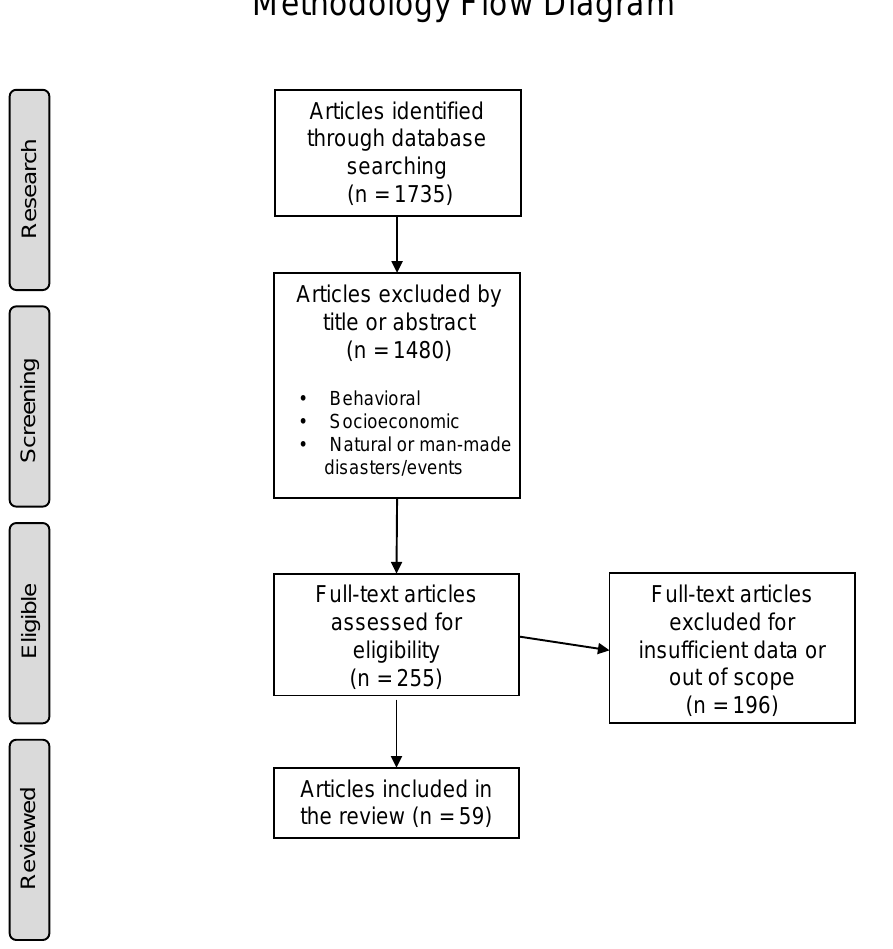
Figure 1. Methodology flow diagram based on